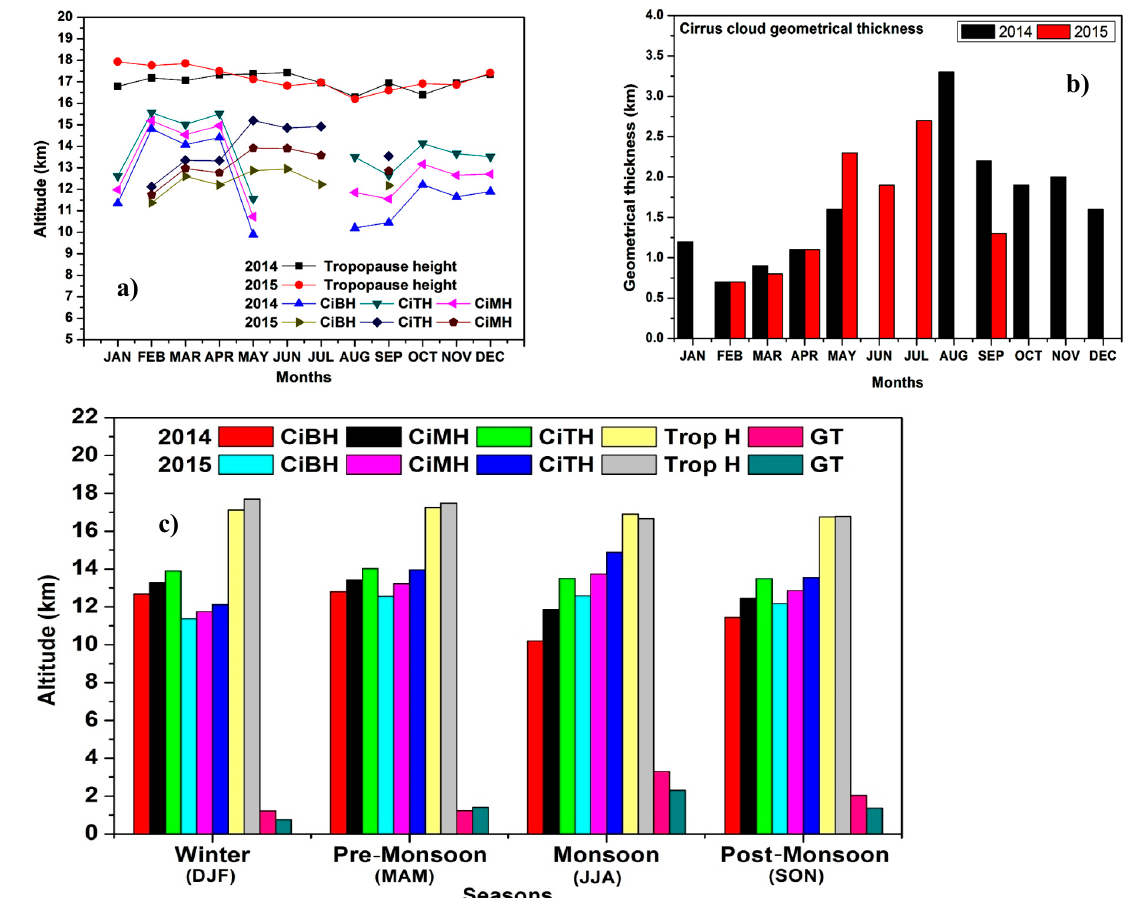
Figure 8. Monthly ( a , b ) and seasonal ( c ) variations of geometrical properties of cirrus clouds as a function of altitude during 2014 and 2015 are shown by di ff erent lines and bar charts. Trop H and GT indicate Tropopause Height and Geometrical Thickness, respectively.